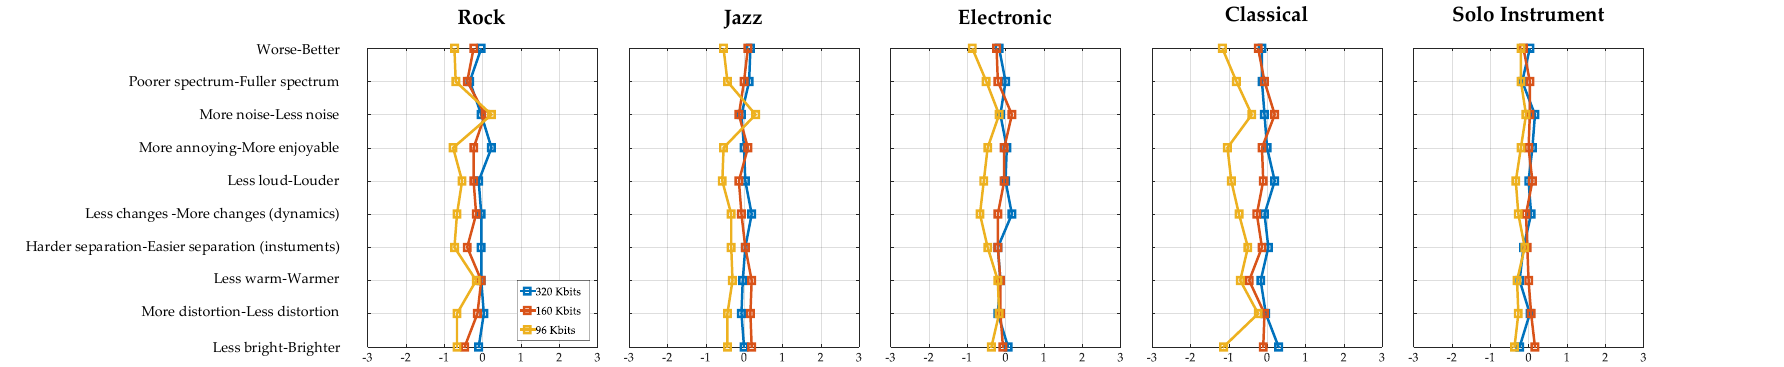
Figure 4. Average evaluation scores for the bipolar scales for each music genre